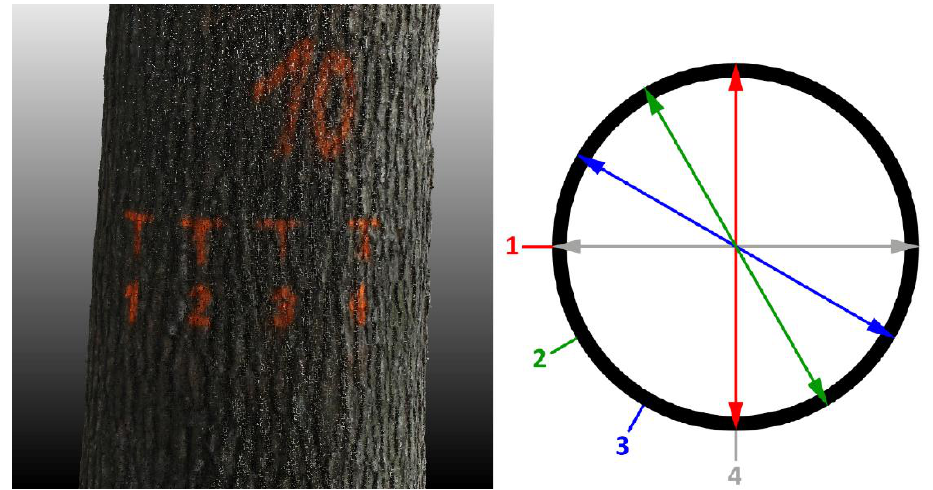
Figure 2. ( left ) Example of the signs for diameter measurement in the field and ( right ) diagram of diameter measurement based on the sign on the bark.